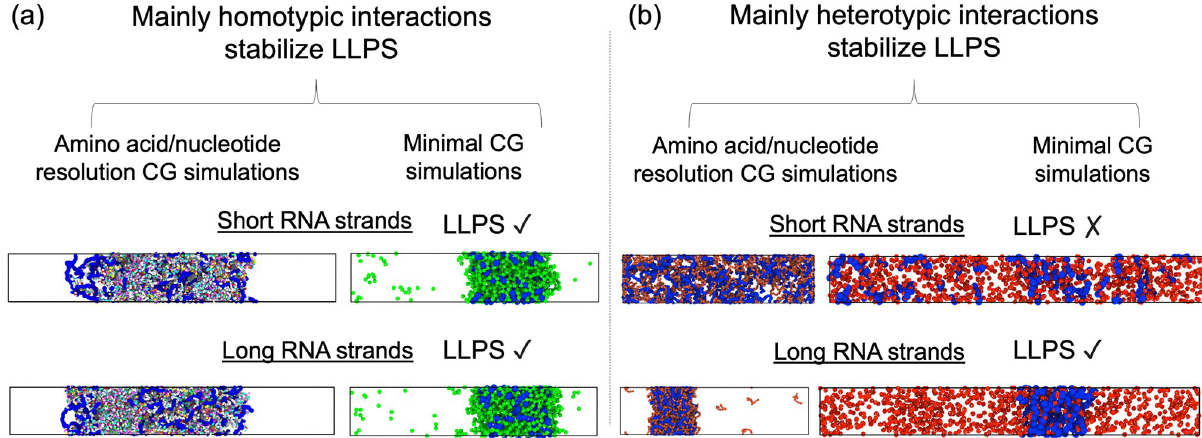
Fig 2. (a) Direct Coexistence simulations of FUS/RNA (left) and scaffold proteins/RNA (right) using short RNA strands (top; 50-mer polyU and 10-bead RNA chains in the FUS and the minimal scaffold protein system respectively) and long RNA strands (bottom; 400-mer and 250-bead RNA chains in the FUS and the minimal scaffold protein system respectively) at T / T each system. (b) Direct Coexistence simulations of PR 25 /RNA (left) and cognate proteins/RNA (right) using both short RNA strands (top; 40-mer polyU and 10-bead polyU RNA chains in the PR 25 and RNA cognate protein system respectively) and long RNA strands (bottom; 400-mer and 250-bead RNA chains in the PR 25 and RNA cognate protein system respectively) at T / T scaffold proteins (right), as in panel (a).